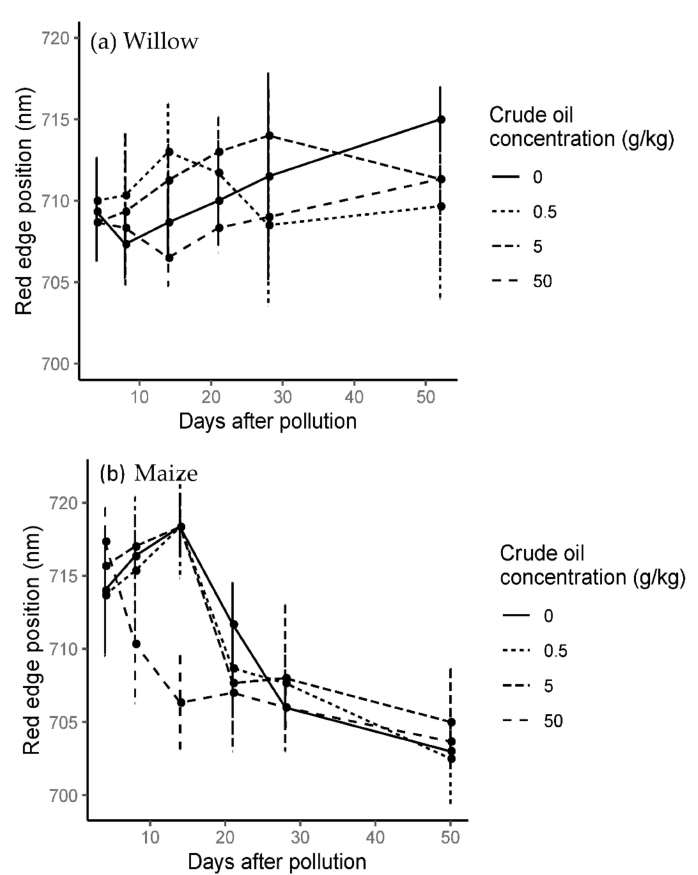
Figure 9. Mean and standard error time series red edge position in crude oil treatments in willow ( a ) and maize ( b ) during the whole experiment. Last spectral measurement of willow was 52 days after the addition of the pollution and last day in the maize experiment was 50 days after the addition of the